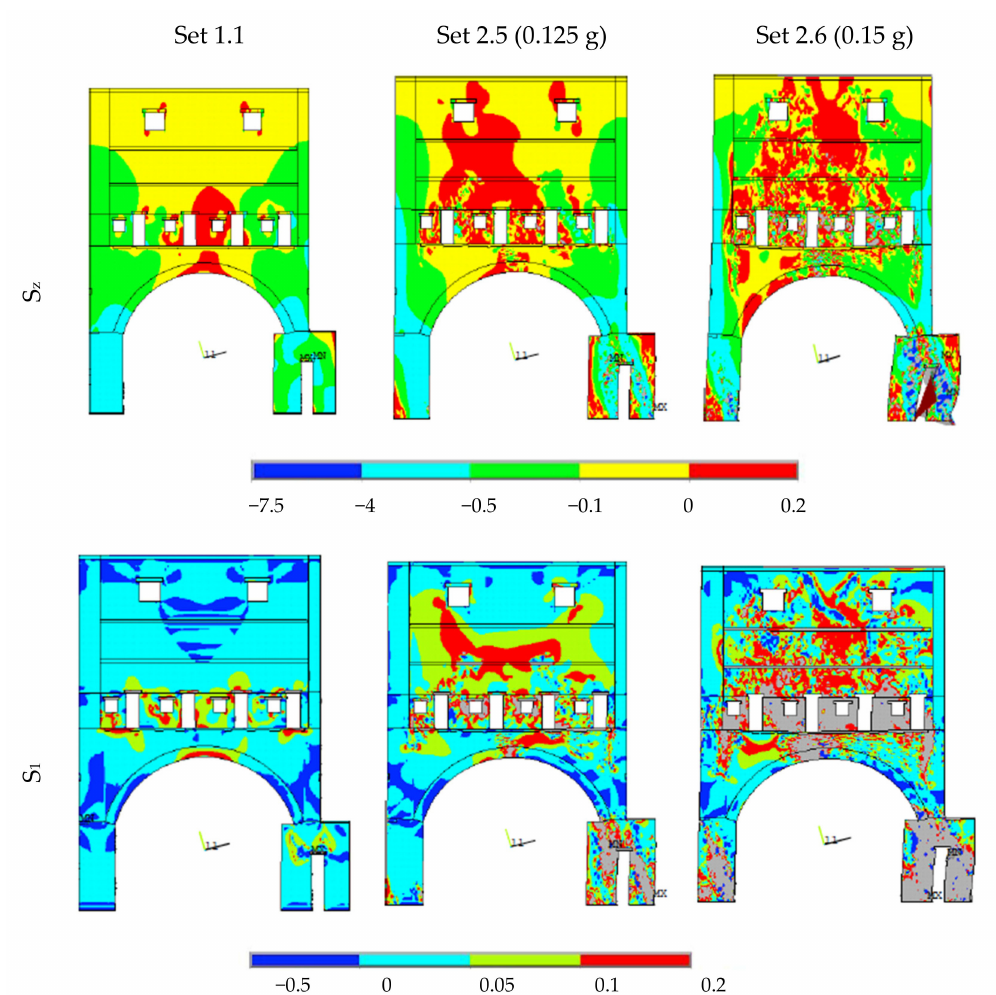
Figure 15. Stress state in [N/mm 2 ] at the end of different set of